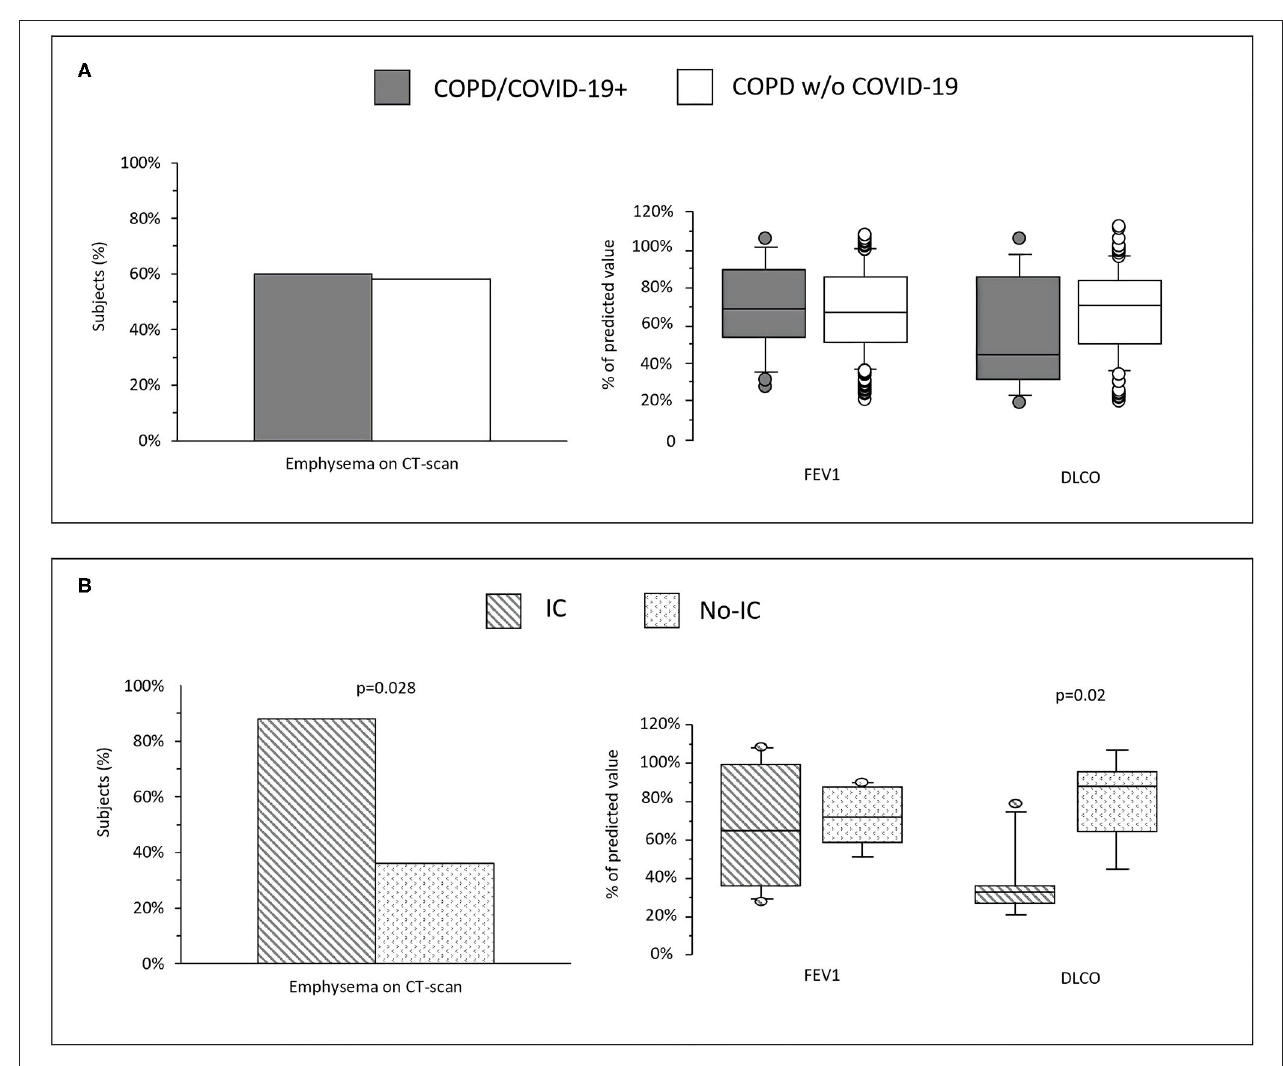
FIGURE 1 | (A) Prevalence of emphysema and values of FEV 1 and DLCO in COPD who developed COVID-19 (COPD/COVID-19 + ) and COPD without COVID-19 (COPD w/o COVID-19). (B) Prevalence of emphysema and values of FEV 1 and DLCO in COPD/COVID-19 + subjects who needed intensive care (IC) and in those who did not